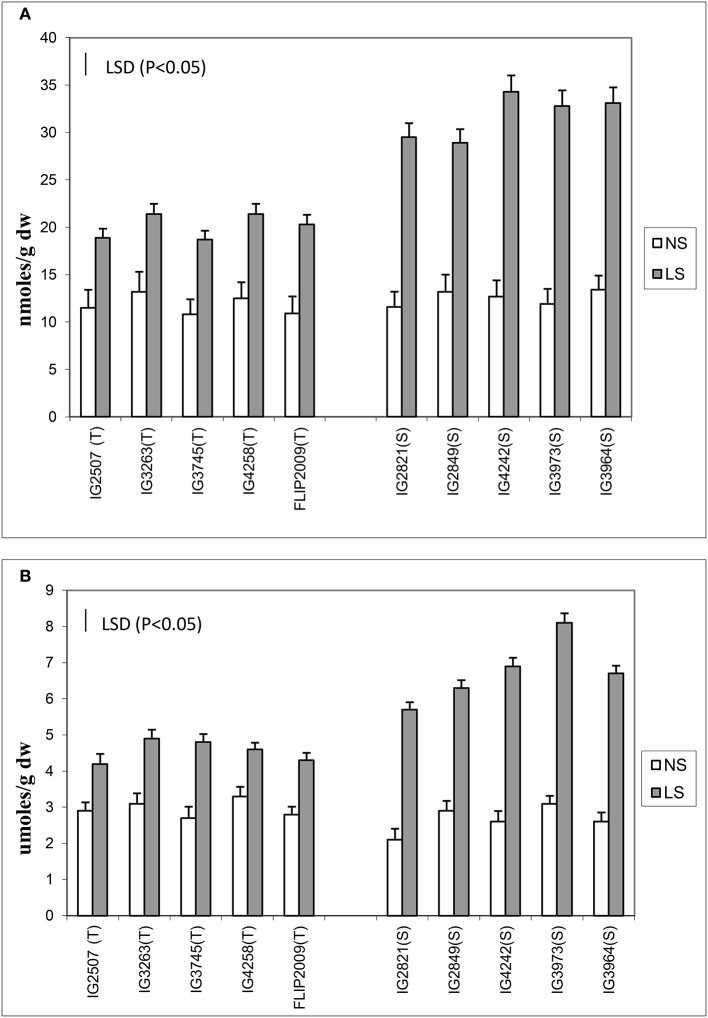
(A) Malondialdehyde (MDA) and (B) hydrogen peroxide (H2O2) concentration in normal-sown (NS) and late-sown (LS) lentil genotypes. Small vertical bars represent standard errors. LSD (P < 0.05; represented as small vertical line close to y-axis) for MDA (2.9) and H2O2 (0.83); T, tolerant; S, sensitive.